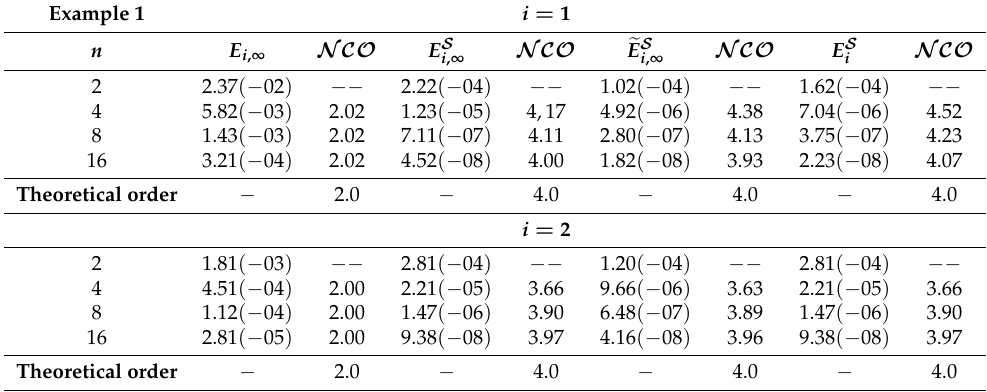
Table 1. Numerical methods based on piecewise constant functions ( r = 1 ) .